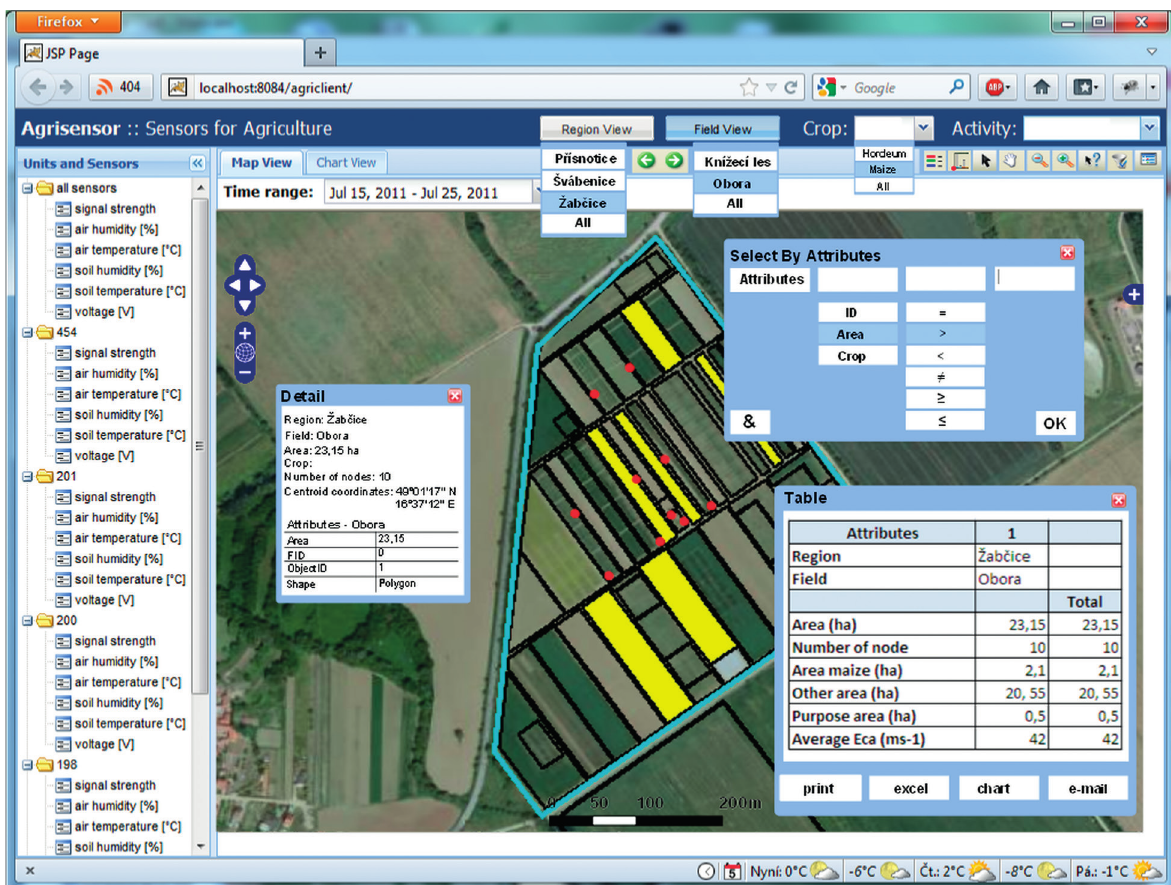
Fig. 3. Map visualizes only sensor units relevant for selected crop – “Maize” – in selected time range – “Jul 15–25” – on selected field – “Obora” – in selected village – “Zabcice”. A selection of units can be done also by table or attributes. Source: Tynklova